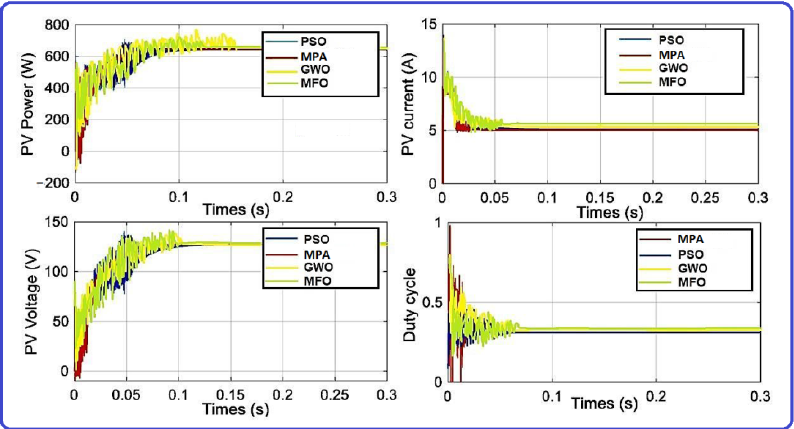
Figure 8. PV power, voltage, current and duty for MPA, PSO, GWO, and MFO during case 2.